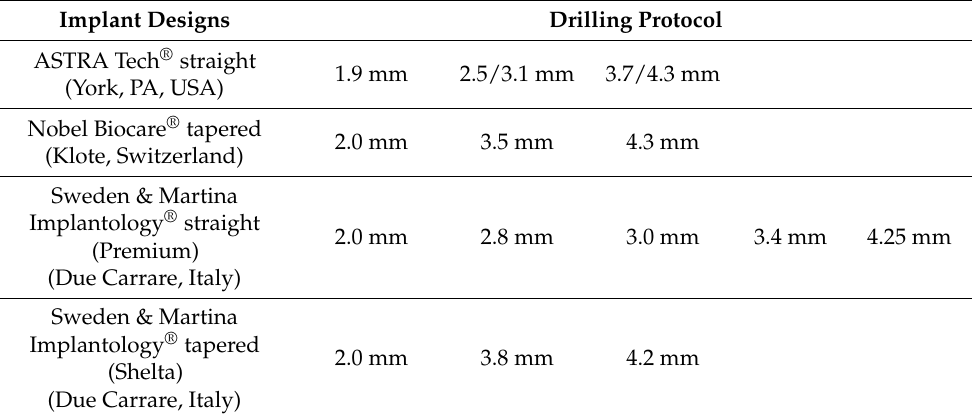
Table 1. The osteotomies were prepared following the manufacturers’ protocol of drill order for a 5 mm diameter dental implant.